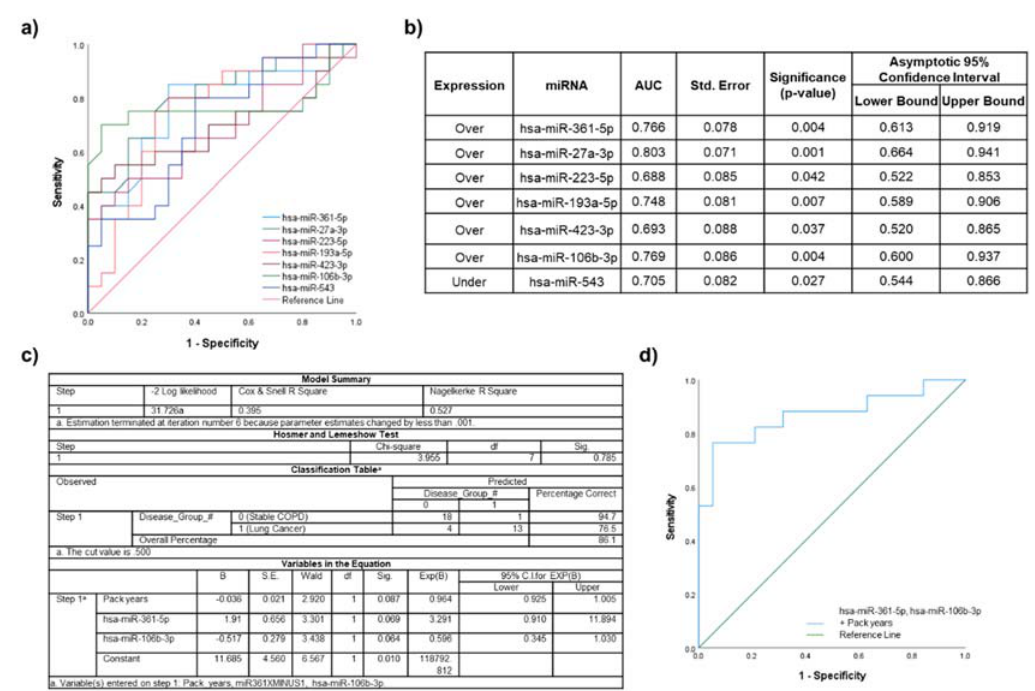
Figure 6. Discriminatory power assessed using ROC curves for the miRNAs that were significantly dysregulated in lung cancer participants compared to stable COPD participants. ( a ) Individual ROC curves for under- and overexpressed miRNAs; ( b ) AUC values, including standard error (Std. Error), significance, and 95% confidence intervals; ( c ) binary logistic regression model for miR-106b-3p and miR-361-5p, as well as significant clinical characteristic (pack years); and ( d ) ROC curve for the logistic regression model.